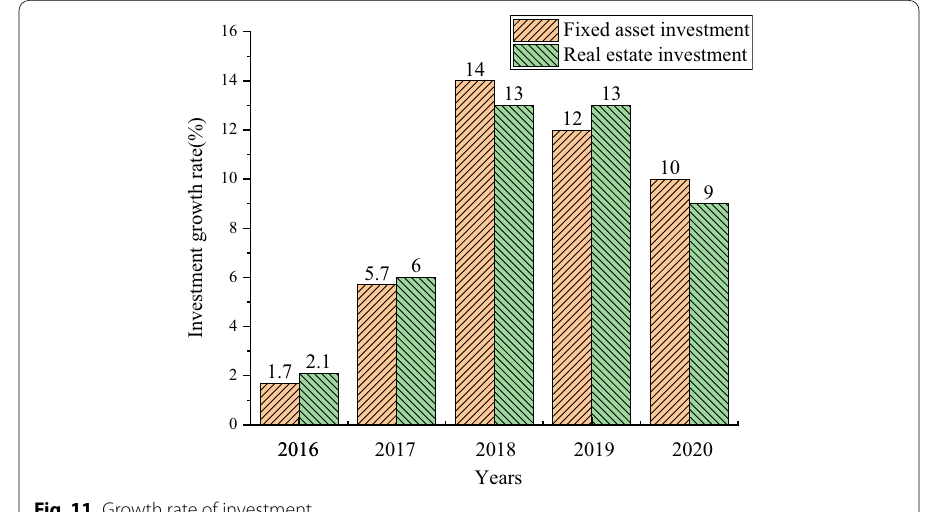
Fig. 11 Growth rate of